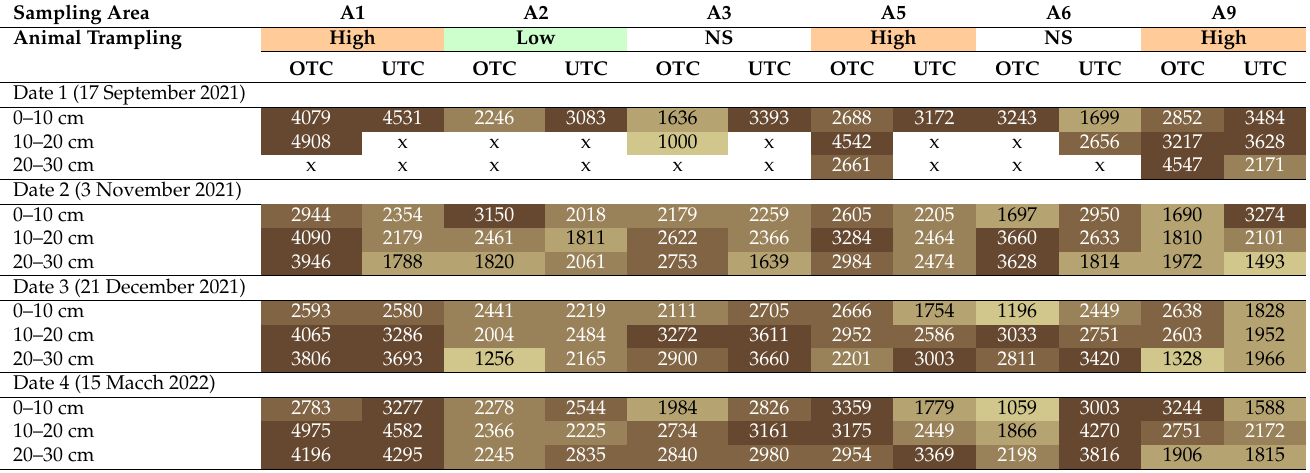
Table 4. Mean Cone Index (CI; kPa) of the sampling areas of Mitra “Field A” on the four evaluation dates (2021/2022), outside and under the tree canopy (OTC and UTC, respectively), and at different depths. Sampling Area